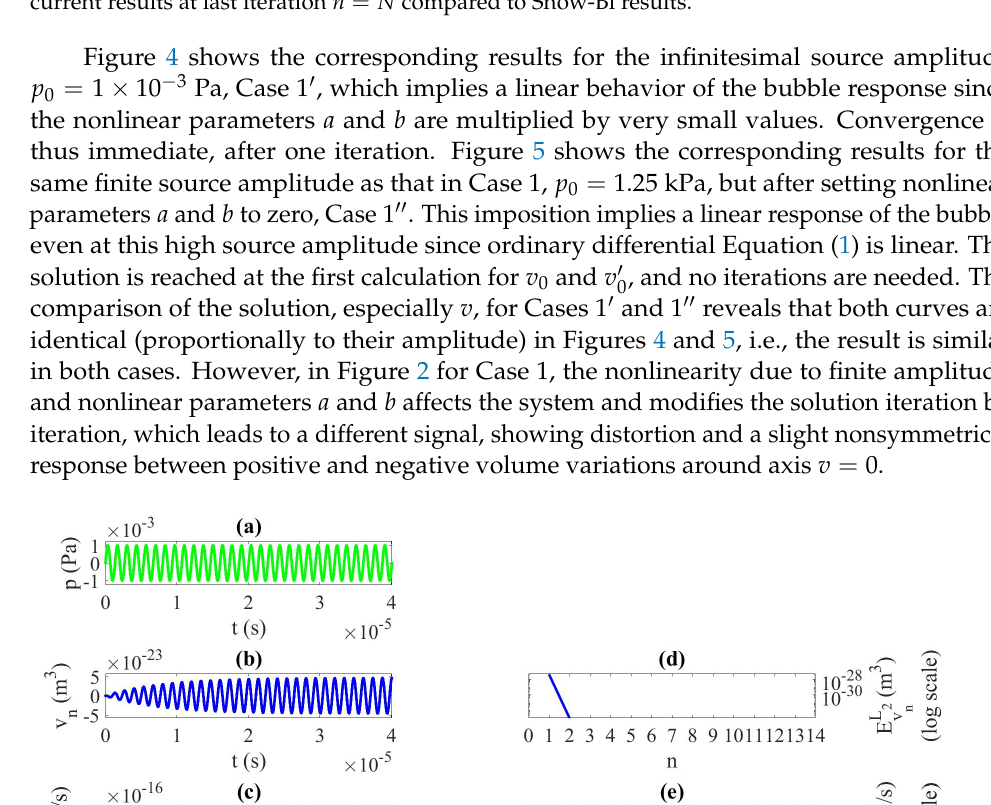
Figure 3. Case 1. f = f b , high finite amplitude with nonlinear terms. Bubble-volume variation; current results at last iteration n = N compared to Snow-Bl results.